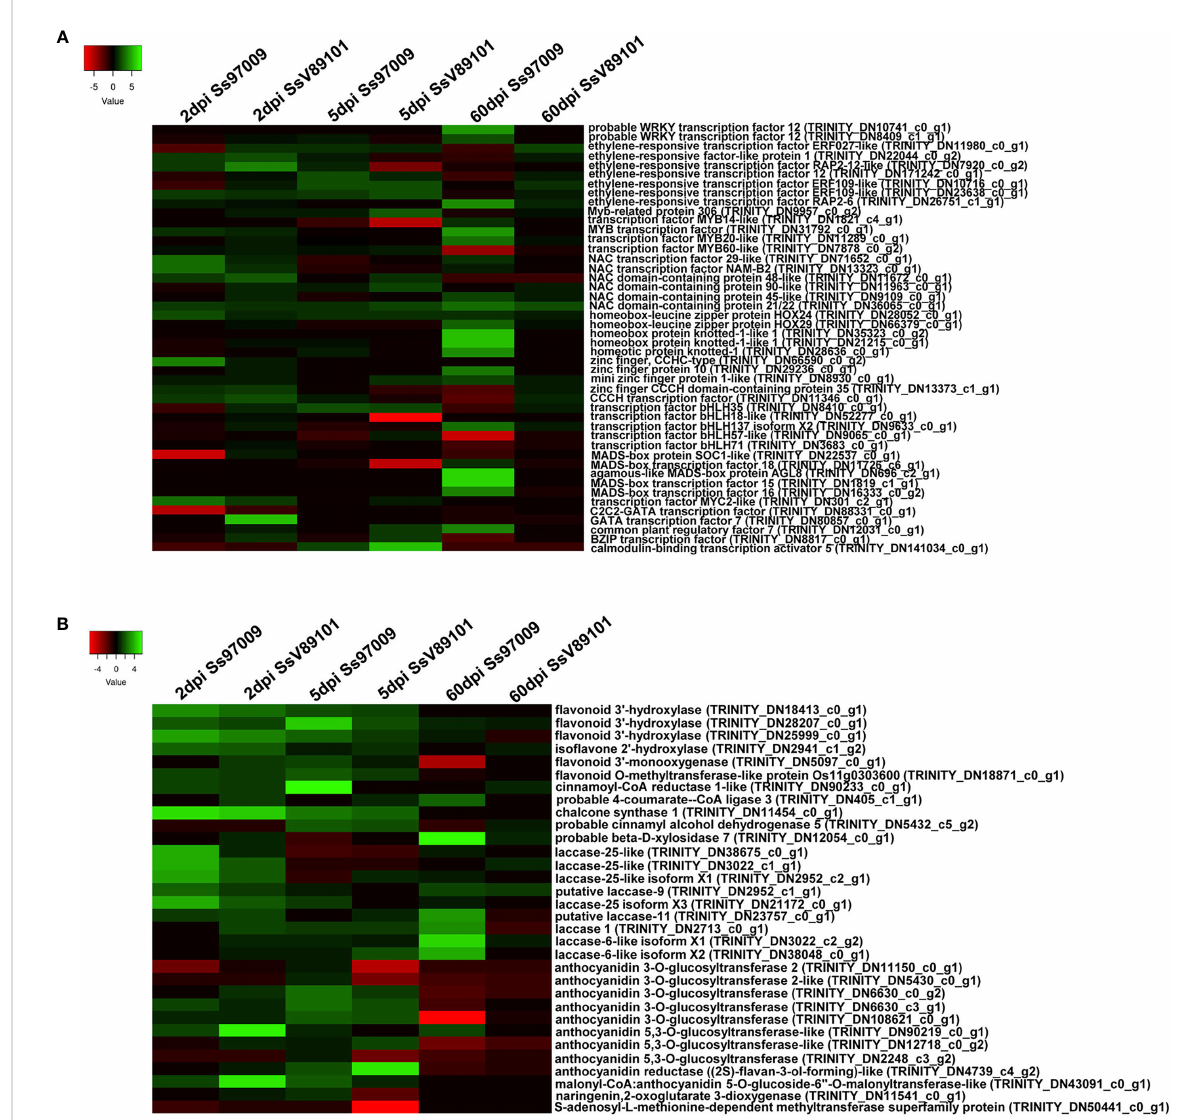
FIGURE 6 Heatmap of the differentially expressed genes (DEGs) in sugarcane cultivar Co 97009 inoculated with the S. scitamineum isolates Ss97009 and SsV89101. (A) DEGs related to transcription factors and (B) fl avonoid biosynthesis pathway with both the isolates at different time intervals (2 dpi, 5 dpi, and 60 dpi). Heatmaps were constructed using the log2 fold change values, and the genes in green and red represent up- and down- regulated genes